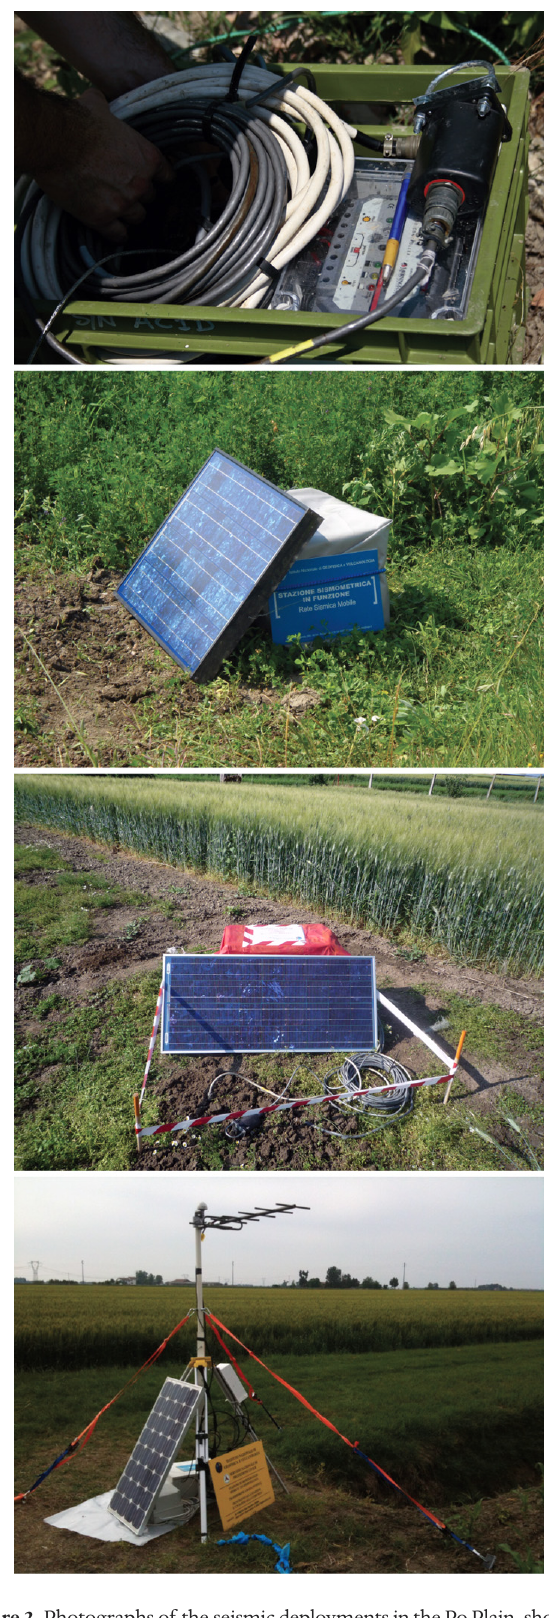
Figure 2. Photographs of the seismic deployments in the Po Plain, showing the standalone recording stations and the stations connected in real-time to the seismic monitoring center in Rome. Top to bottom: the seismic stations (digitizer, GPS, battery and cables) are transported and installed inside a plas- tic case. The case is covered by a tarpaulin and a sign explains the instru- ment scope and gives contact information. Most of the stations are powered with solar panels; the sensor is buried inside a plastic bag close to the sta- tion. Stations transmitting data in real-time are equipped with